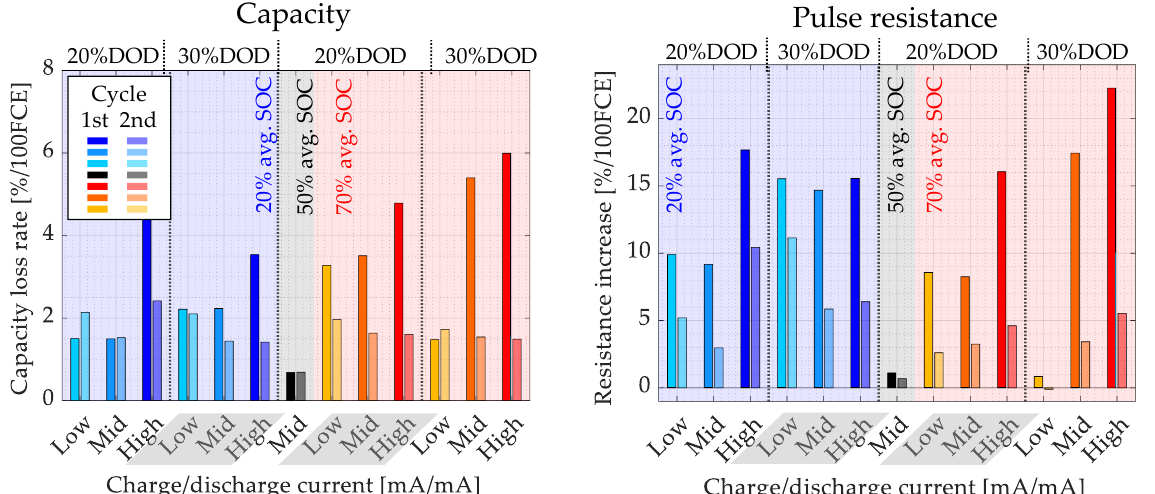
Figure 6. Rates of the apparent capacity loss and resistance increase during the cycling phases. The cells were tested with 20%, 50%, and 70% average SOC (red, grey, and red background), 20% and 30% DOD, and low (1020 mA/2000 mA), mid (1360 mA/2800 mA) and high (1700 mA/3400 mA) charge/discharge currents.